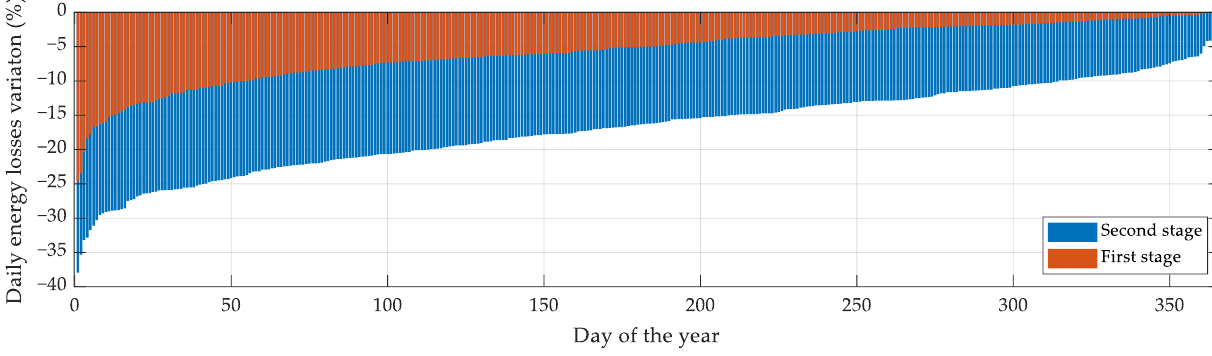
Figure 15. Daily energy losses variation between each stage of LARPC and OARPC